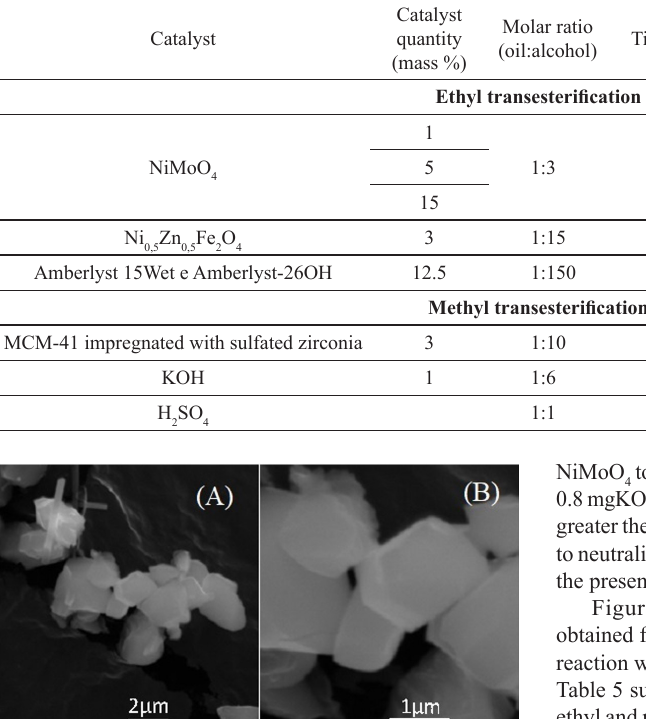
Table 5. Acidity index and reaction conditions of ethyl and methyl transesterification of soybean oil.